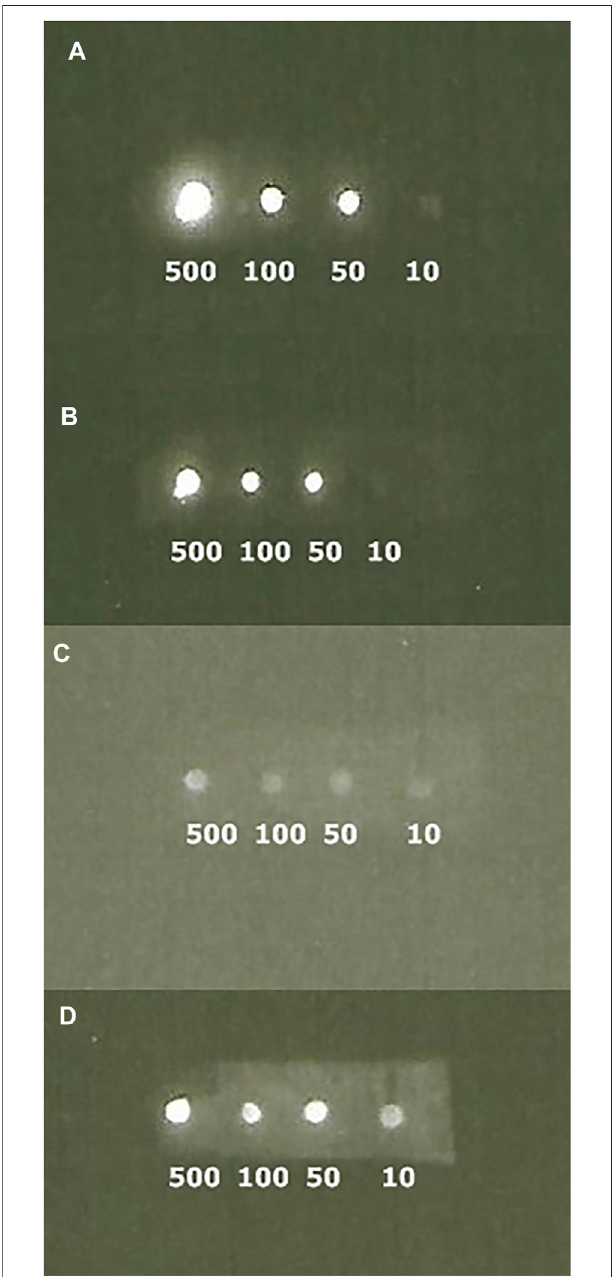
FIGURE 5 | CCDimaging of Dot blots comparing the luminescent signal of primary polyclonal antibodies raised against limpet hemocyanin revealed with ZZ-AmyLuc fusion protein (A and B) and commercial HRP-labeled secondary antibody (C and D): (A) revealed with ZZ-AmyLuc fusion protein and its assaysolutionafter1 minexposure; (B) sameexperimentofAafter2 hincubation at room temperature and 1 min exposure; (C) revealed with commercial HRP- labeledsecondaryantibodyanditsassaysolutionfromGEHealthCareafter1 min exposure and (D) same experiment of C after 5 min exposure.